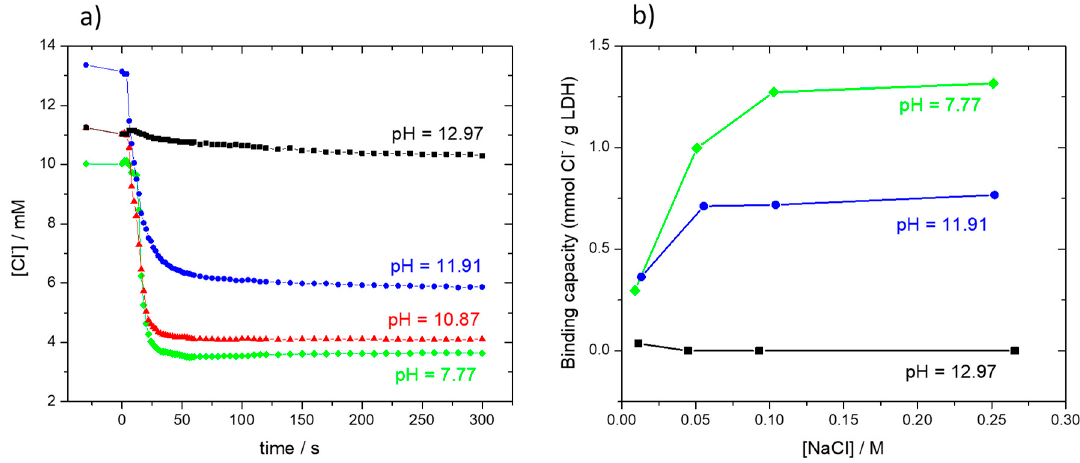
Figure 4. ( a ) Decrease of chloride concentration of 0.01 M NaCl solution at different pH after the addition of ZnAl-NO 2 (solution volume = 50 mL, 1 g of LDH added at time t = 0); ( b ) Chloride binding capacity of ZnAl-NO 2 at different pH and chloride concentrations.